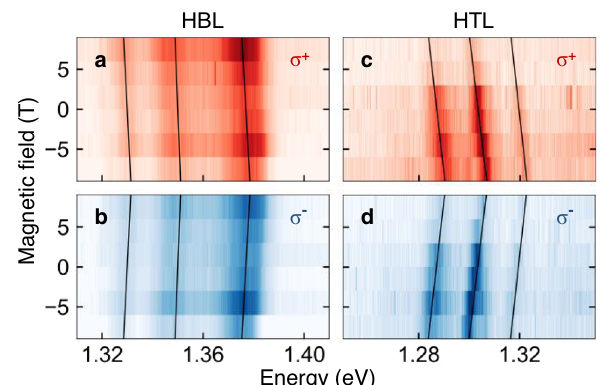
Fig. 4 Valley Zeeman shift of interlayer excitons in MoSe 2 -WSe 2 heterobilayer and heterotrilayer. a , b Magneto-luminescence of twisted HBL MoSe 2 -WSe 2 for linear excitation and σ + (red) and σ − (blue) circularly polarized detection, respectively. c , d Same for HTL MoSe 2 -WSe 2 . The solid lines show magneto-induced energy shifts of HBL and HTL peaks with g -factors (from high to low energy) and error bars from least-square linear fi ts of − 6.2±0.8, − 4.2±0.8, and − 5.5±0.8, and − 12.0±2.0, − 12.0±0.8, and − 13.0 ± 0.8,